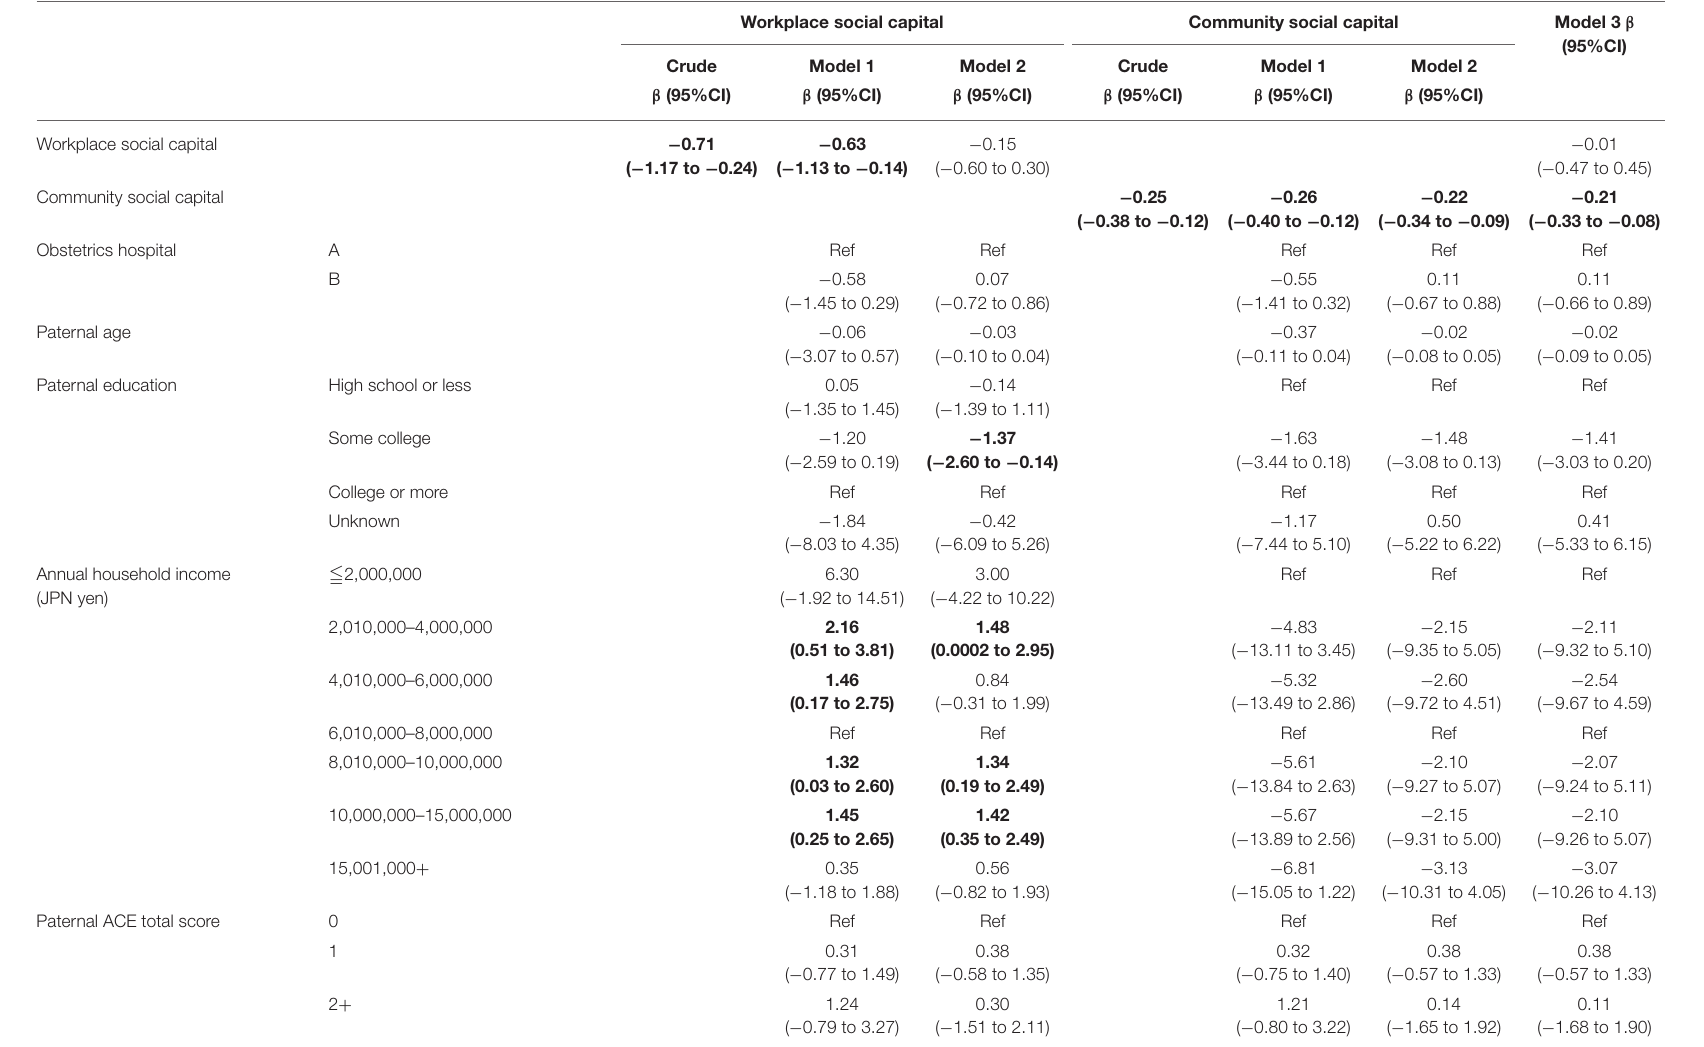
TABLE 3 | Association between paternal social capital and paternal depressive symptoms at 3 months after delivery after multiple